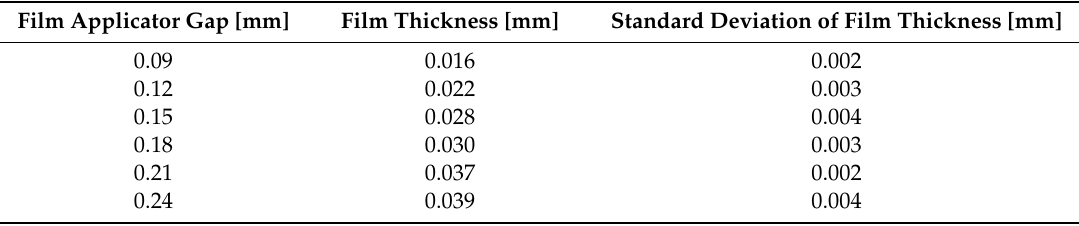
Table 1. Film applicator gap sizes with the corresponding real film thicknesses.